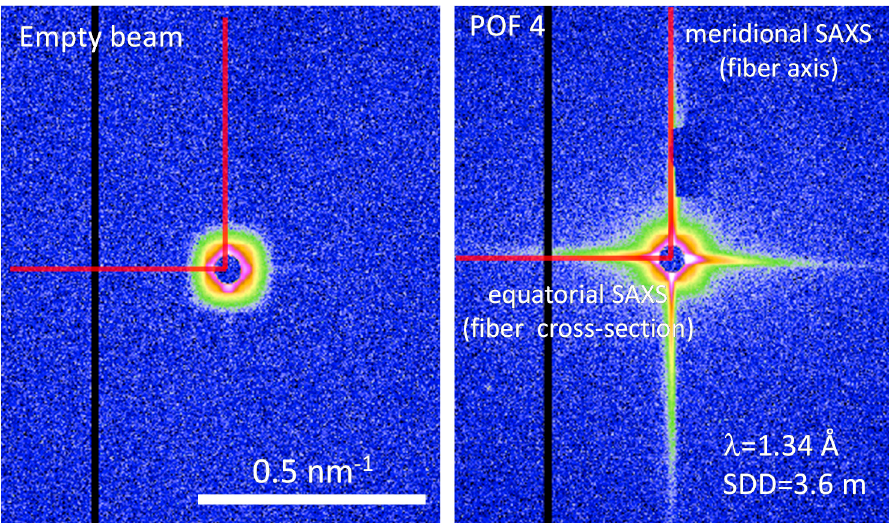
Figure 3. ( Left ) 2D-SAXS intensity distribution of the empty beam displaying an isotropic scattering. ( Right ) 2D-SAXS intensity distribution of the sample POF 4. The strong anisotropic equatorial and meridional scattering indicates that at least parts of the PMMA chains are highly oriented. Note that the color codes of empty beam and sample scattering are not to scale. The empty beam scattering intensity is on average about two orders of magnitude smaller than the small-angle scattering arising from the fiber sample.